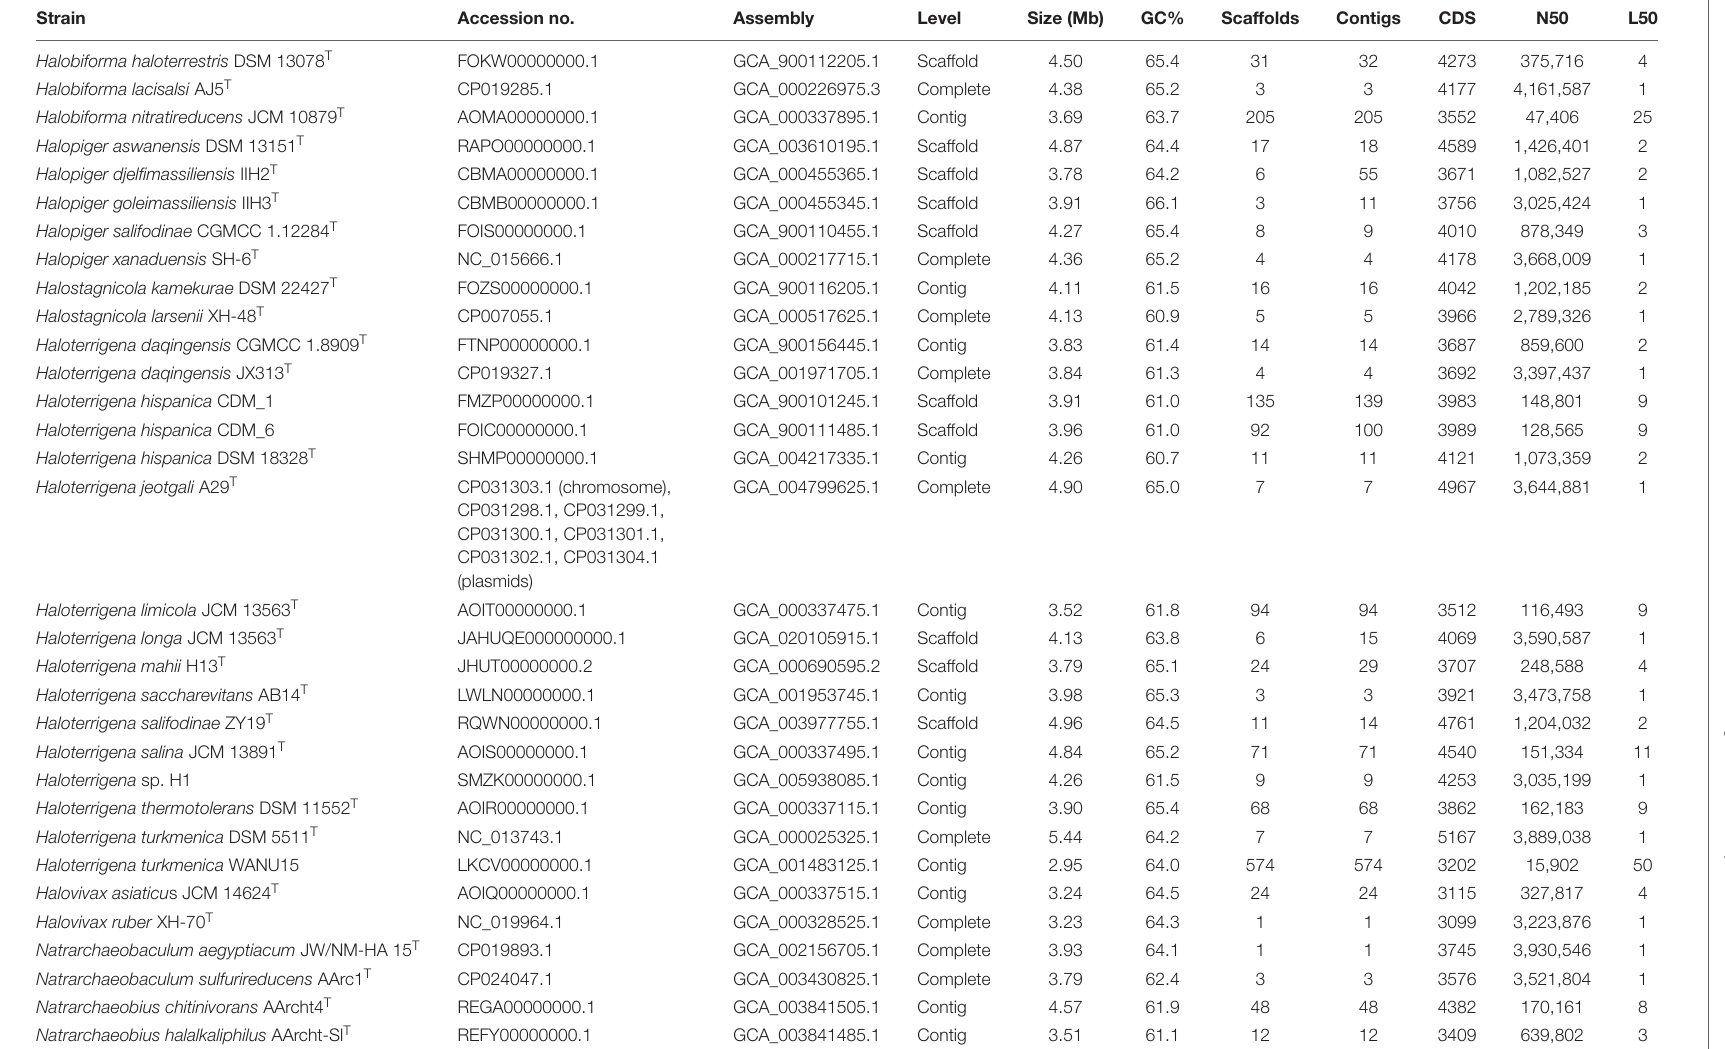
TABLE 1 | Main features of genome sequences of strains of the family Natrialbaceae used in this study.